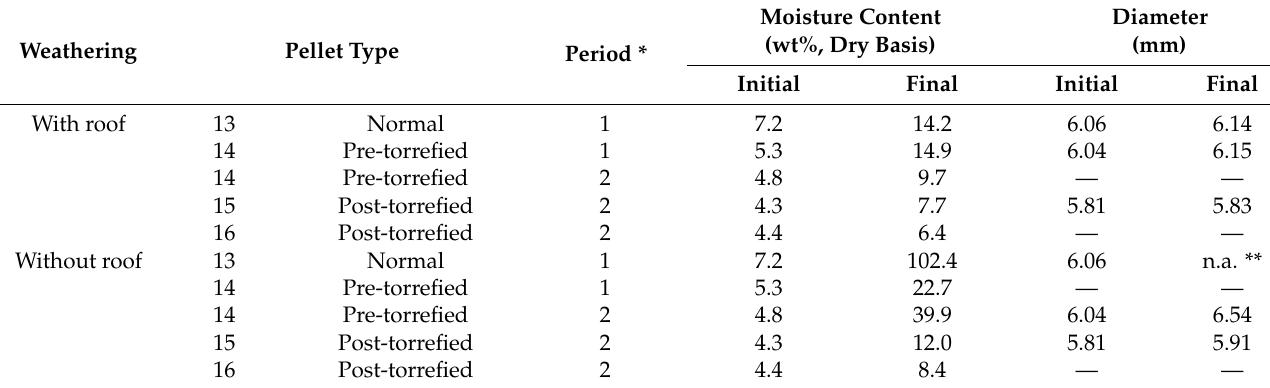
Table 3. Moisture content and pellet diameter during the weathering test.